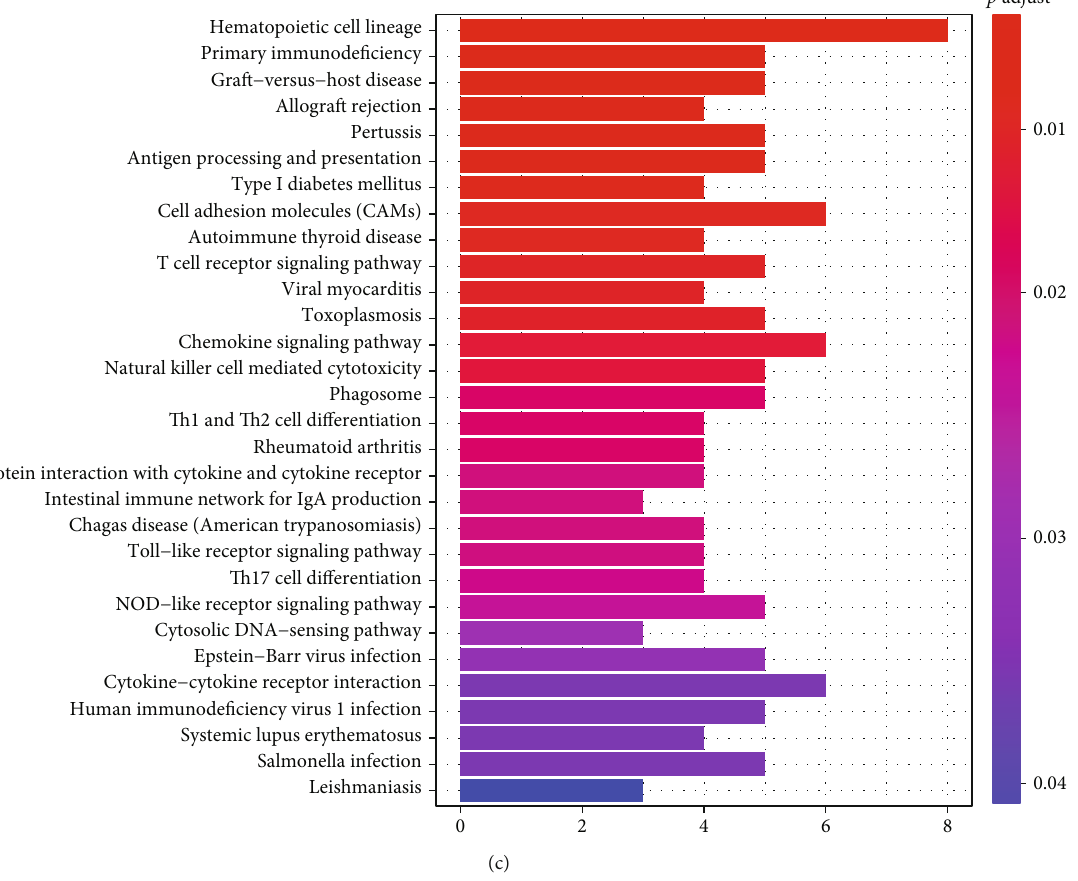
Figure 3: Relationship between DElncRNAs and DEmRNAs and corresponding functional enrichment analysis of DEmRNAs. (a) The DElncRNA-DEmRNA regulatory relationship network. The orange nodes represent the common DElncRNAs. The purple nodes represent the DEmRNAs correlated with the DElncRNAs. The relationship is shown based on Pearson correlation analysis with the criteria of ∣ r ∣ >0 : 7 and p value < 0.05. (b) GO functional enrichment analysis of DEmRNAs involved in the network. (c) KEGG functional enrichment analysis of DEmRNAs involved in the network. DElncRNAs: di ff erentially expressed lncRNAs; DEmRNAs: di ff erentially expressed mRNAs; GO: Gene Ontology; KEGG: Kyoto Encyclopedia of Genes and